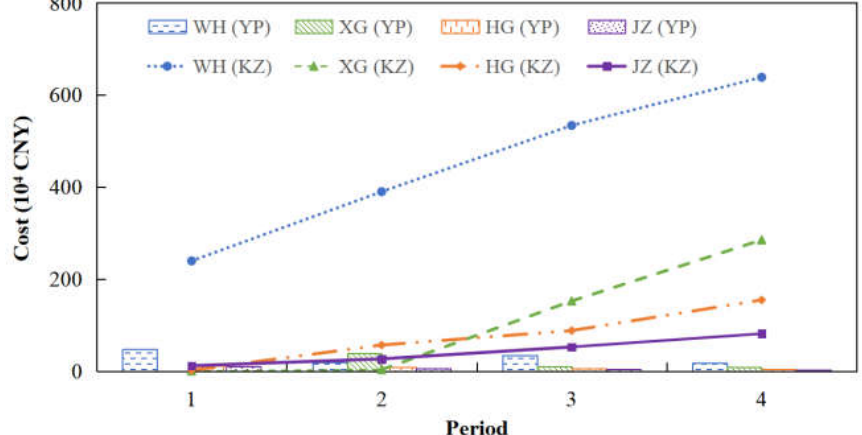
Figure 7. Time required to obtain emergency materials at each affected site in each time period based on the balance-criterion.